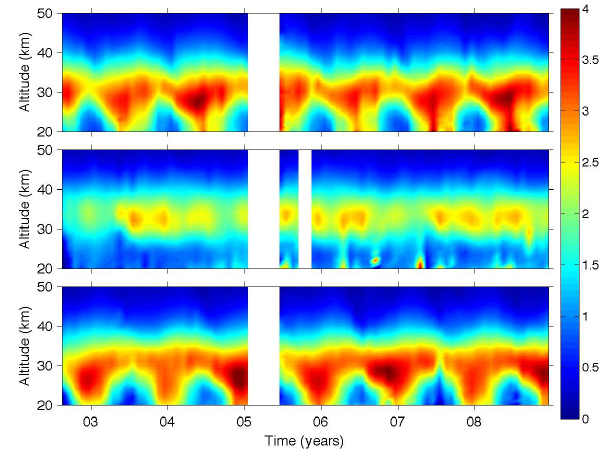
Fig. 15. Correlations of the monthly ozone median densities with the monthly median temperatures (from ECMWF) as a function of altitude. Left: 30 ◦ S–50 ◦ S, Middle: 10 ◦ S–10 ◦ N, Right: 30 ◦ N– 50 ◦ N. Line identifications: DJF: blue, MAM: red, JJA: green, SON: cyan.